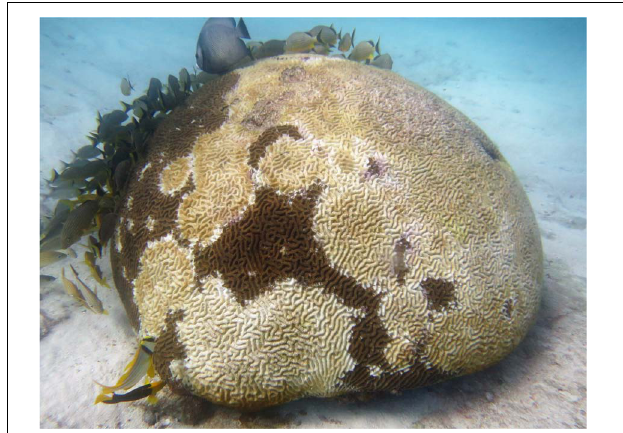
FIGURE 5 | Stony Coral Tissue Loss Disease on a Colpophyllia natans coral head in David Reed, Upper Florida Keys. Photo by Jennifer Stein (The Nature Conservancy) in